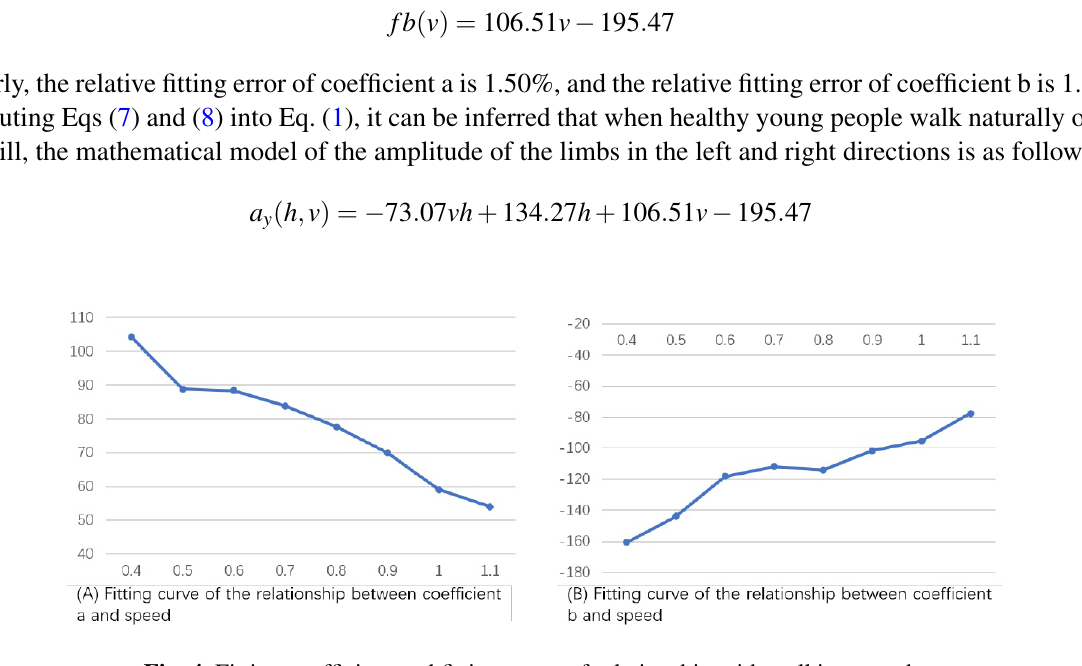
Fig. 4 Fitting coefficient and fitting curve of relationship with walking